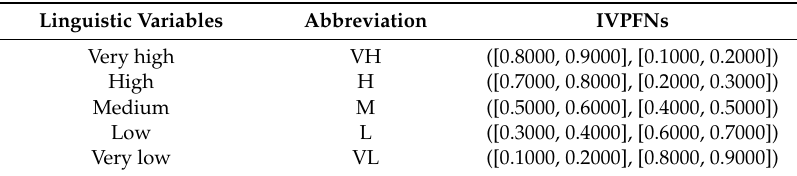
Table 2. Linguistic terms for rating the weights of risk factors